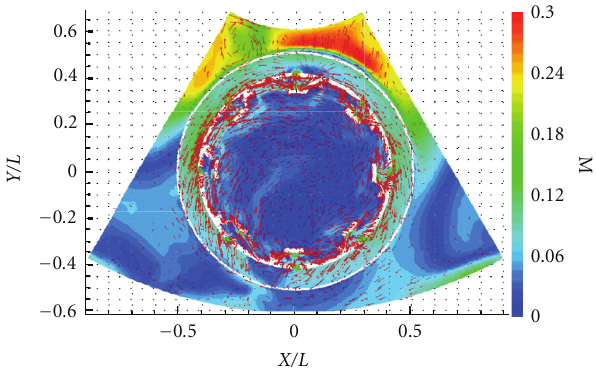
Figure 8: Velocity vectors and Mach numbers at a dome swirler cross-section.